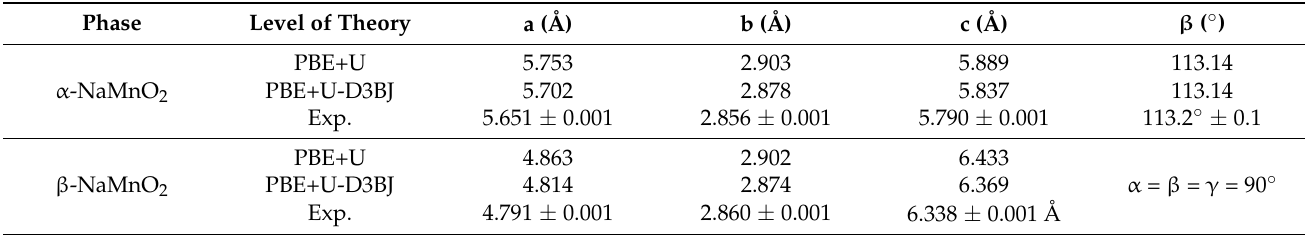
Table 3. Lattice parameters of both α - and β -NaMnO 2 minimum-energy structures obtained at PBE+U and PBE+U-D3BJ levels of theory.